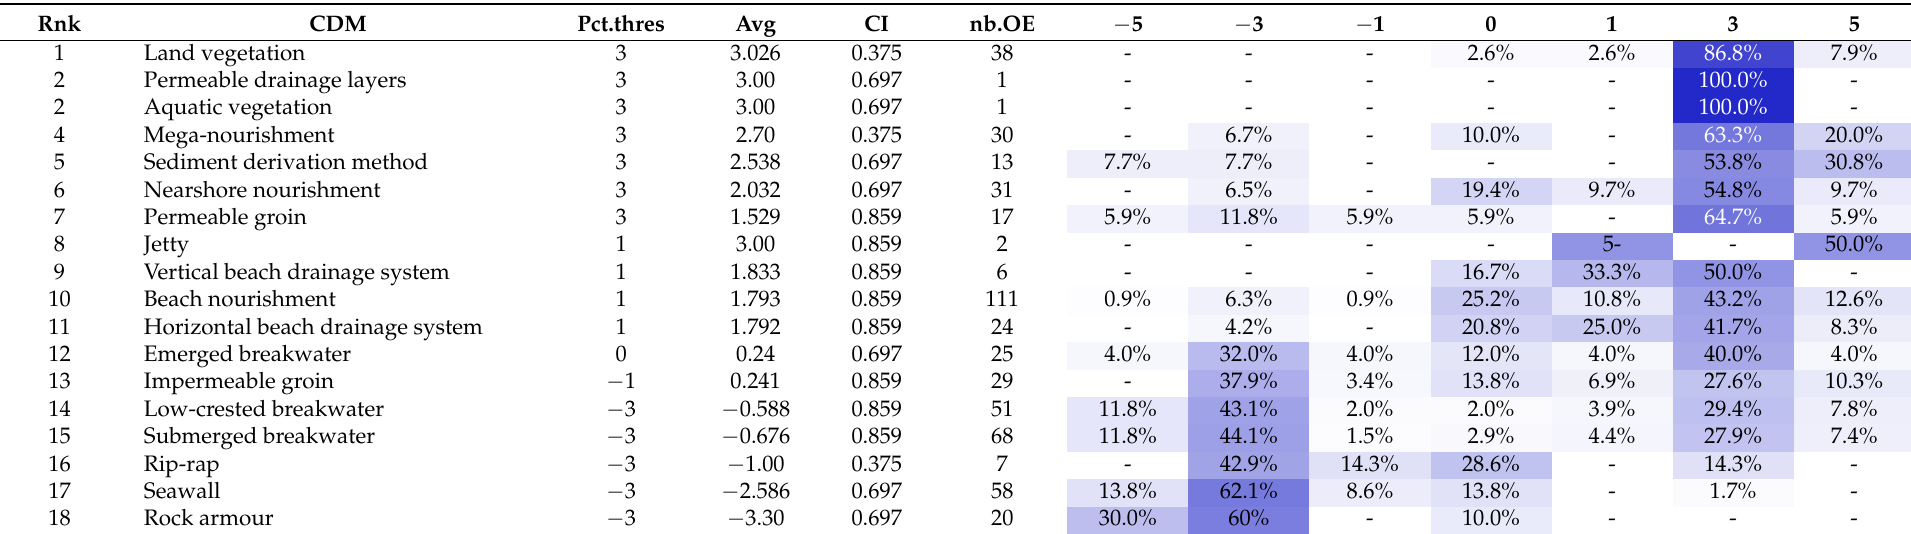
Table 10. Summary hierarchization resulting from the evaluation of CDM geomorphological effects. The results presented, as an example, are in an environmental context described as littoral sandy spit, mesotidal coast, and low energy wave climate (Hs < 1.0 m). The background blue shades is used to give a visual indication of the distribution of the nb.OE on the weighting